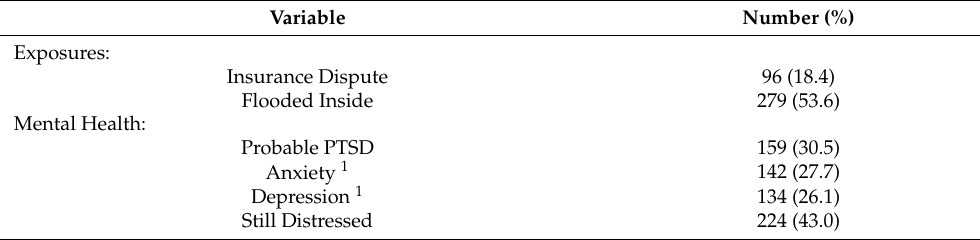
Table 2. Prevalence of exposures and mental health and wellbeing outcomes.